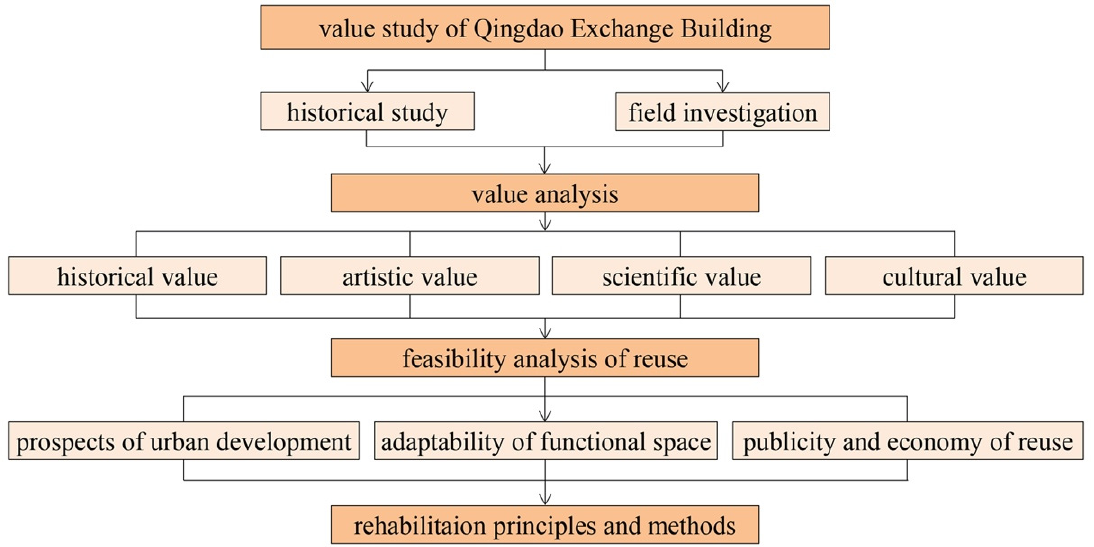
Figure 4. Research